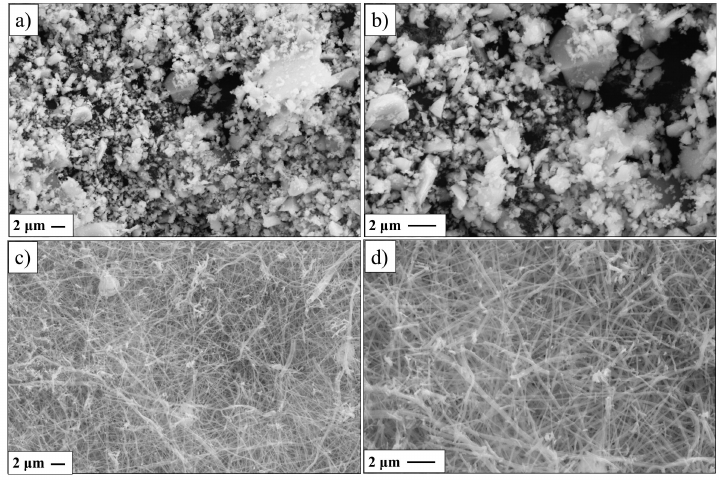
Figure 1. SEM images: ( a , b ) LSM powders; ( c , d ) LSM